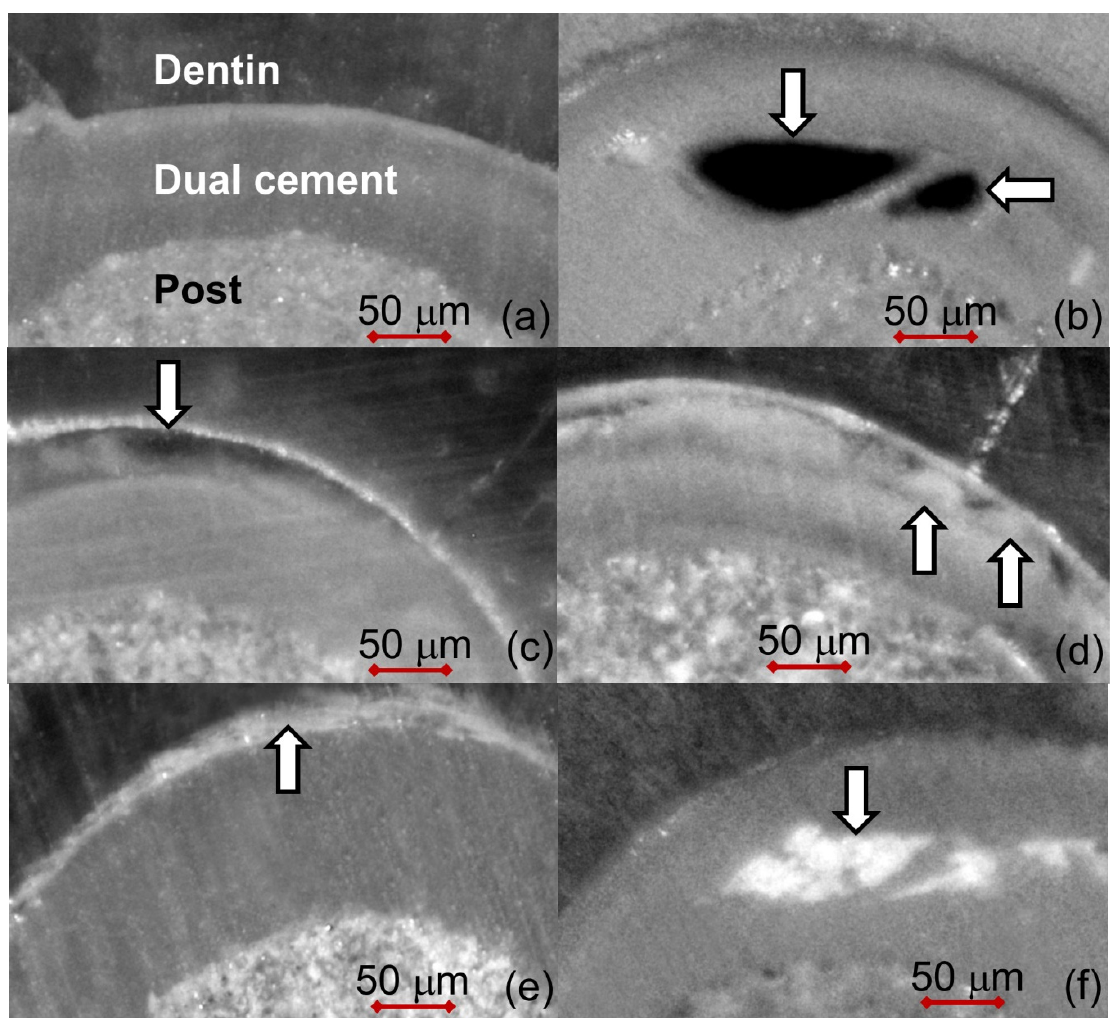
Figure 2. Seventy-micrometer thick unstained sections (enlargement of 40×): White arrows indicate the five defects detected: ( a ) defectless slice; ( b ) bubbles within the dual cement layer; ( c ) detachments at the dual cement-dentin interface; ( d ) polymerization defects within the dual cement layer (pol.def.); ( e ) endodontic cement residues at the dual cement-dentin interface (int.res.); and ( f ) embedded residues of endodontic cement into the dual cement layer